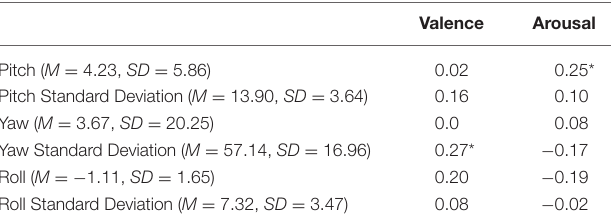
TABLE 2 | Correlation matrix of head movement data and affective ratings ( N = 73).